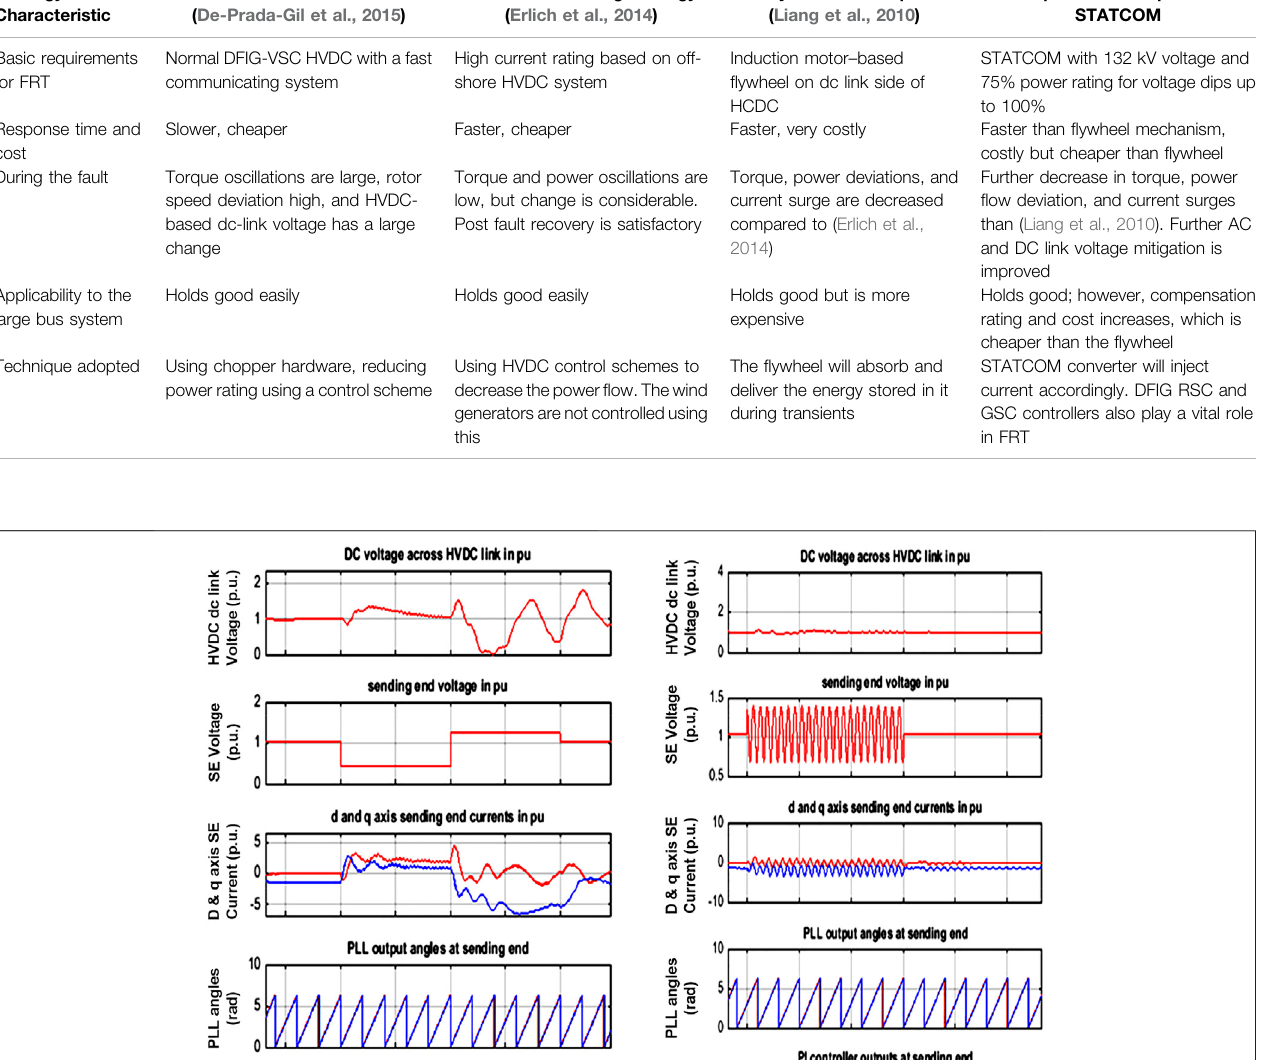
Frontiers in Energy Research |